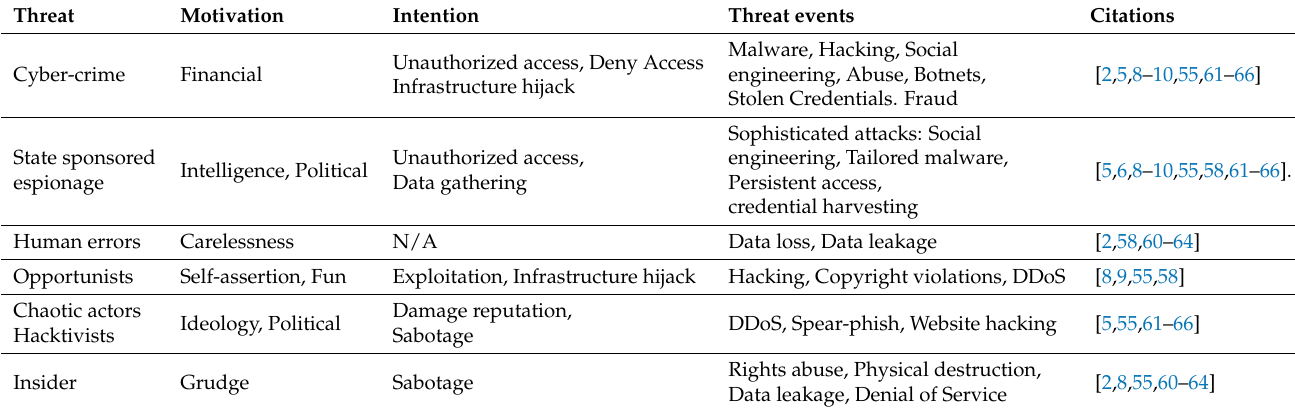
Table 13. Proposed generic threat model for HE, sorted on threat, motivation, intention, events, and likelihood